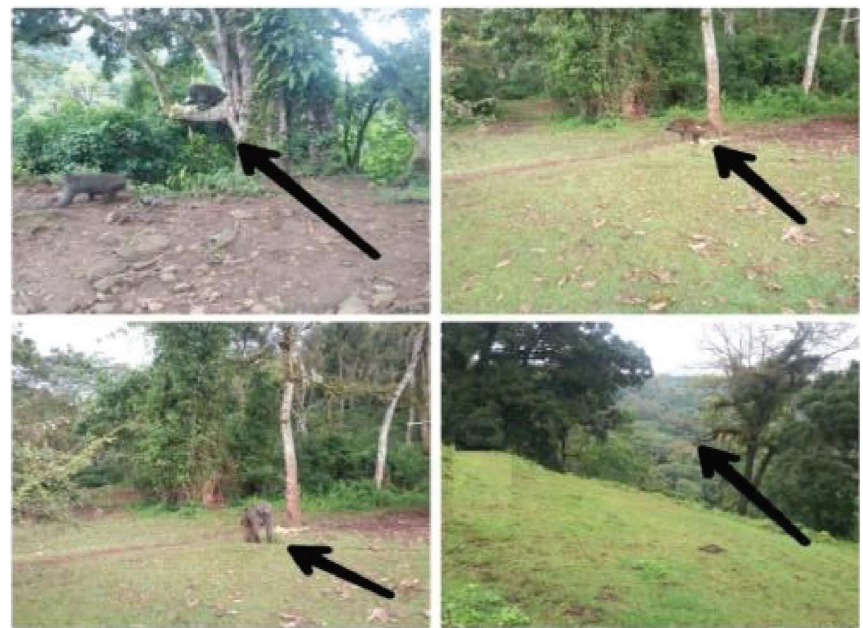
Figure 2: Anubis baboons damaging crops in the study area. Table 2: Te number of damaged plants and percentage of maize crop fed by olive baboons at each development stage per hectare. Kebeles